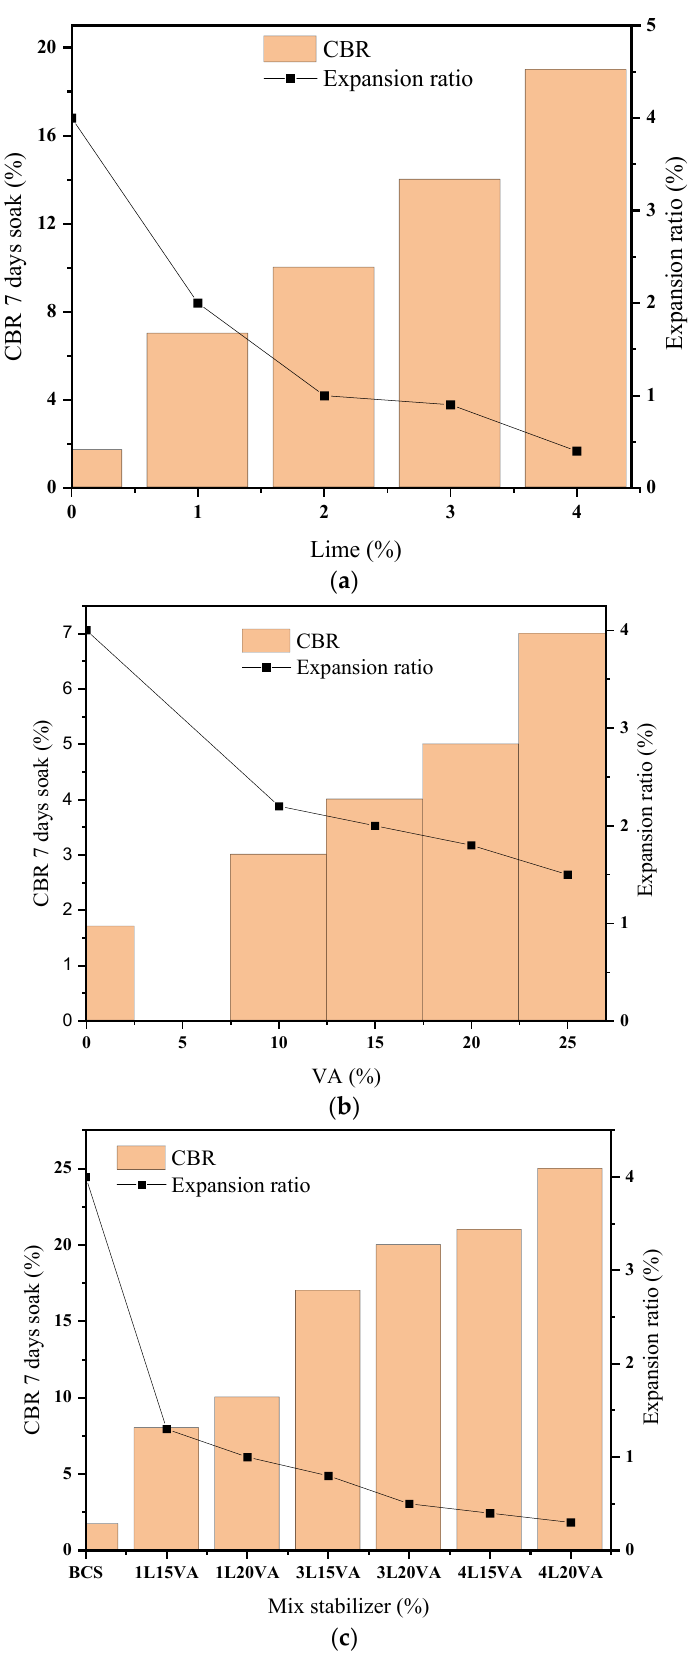
Figure 7. Effects of ( a ) lime, ( b ) volcanic ash and ( c ) a combination of volcanic ash on CBR and the swell percent value of BCS.